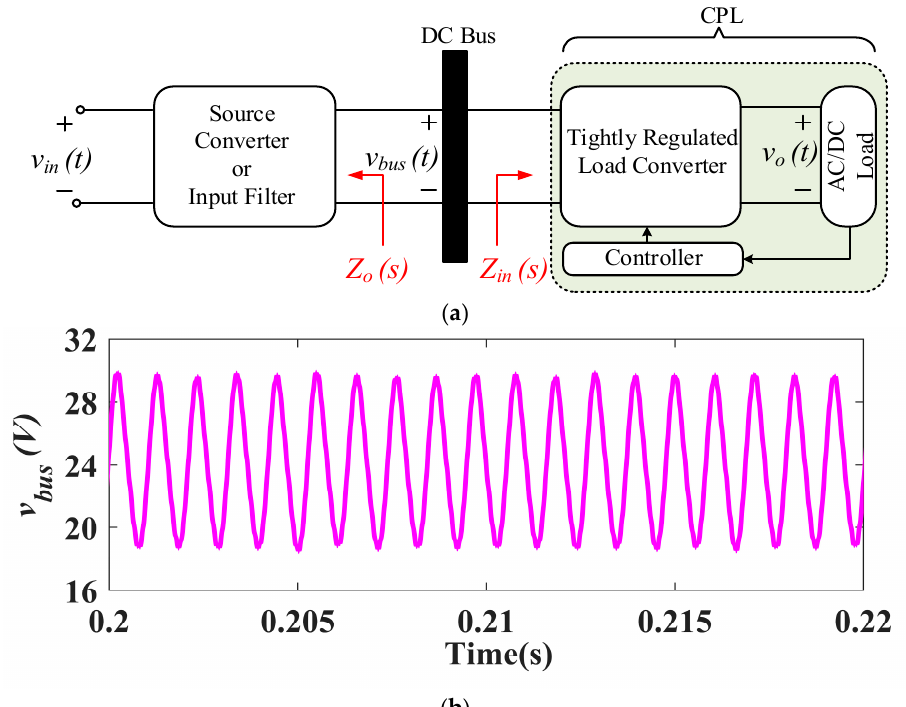
Figure 3. ( a ) A generic cascaded system feeding CPL. ( b ) Observed oscillation in DC bus voltage caused by CPL.